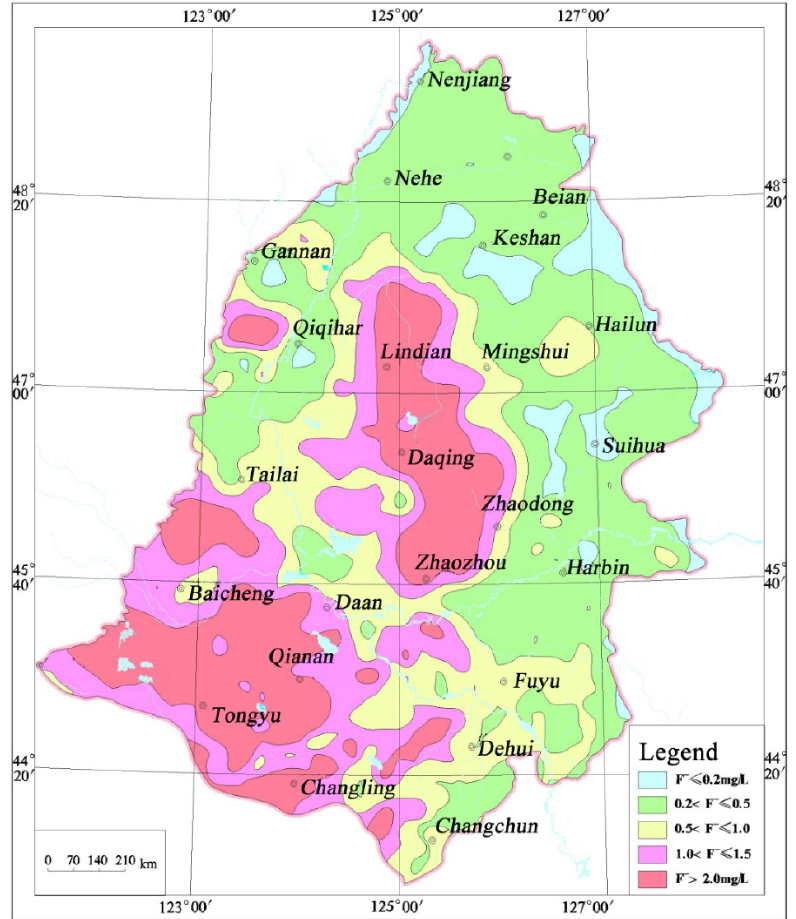
Figure 3. Distribution of fluorine in groundwater.